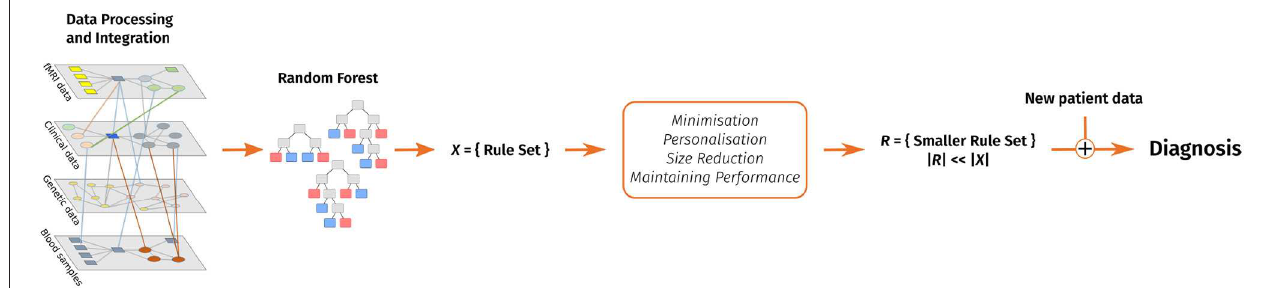
FIGURE 1 | A visual overview of our clinical decision support system. Data pre-processing includes feature extraction. After that, a random forest is trained and converted into a rule set. This rule set is then reduced with the goal of keeping the performance and considering personal preferences in form of favorite features and enables to make a diagnosis on new patient